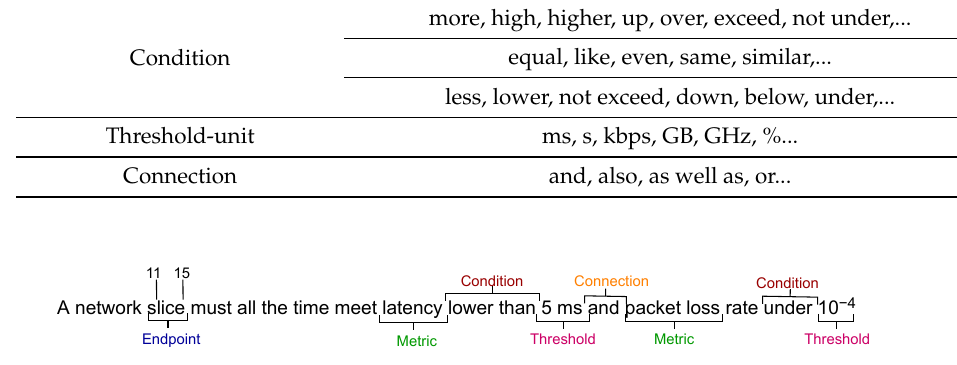
Figure 4. Identification of entities in a Goal